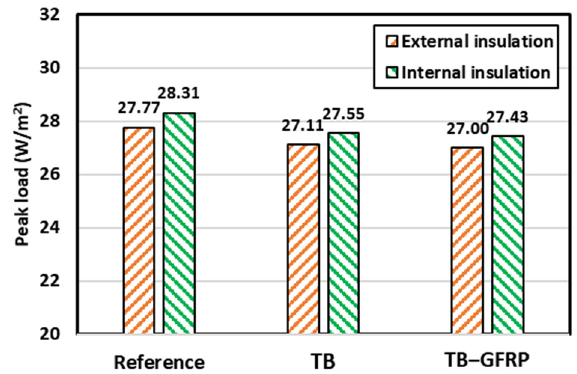
Figure 8. Peak heating load under air heating conditions.